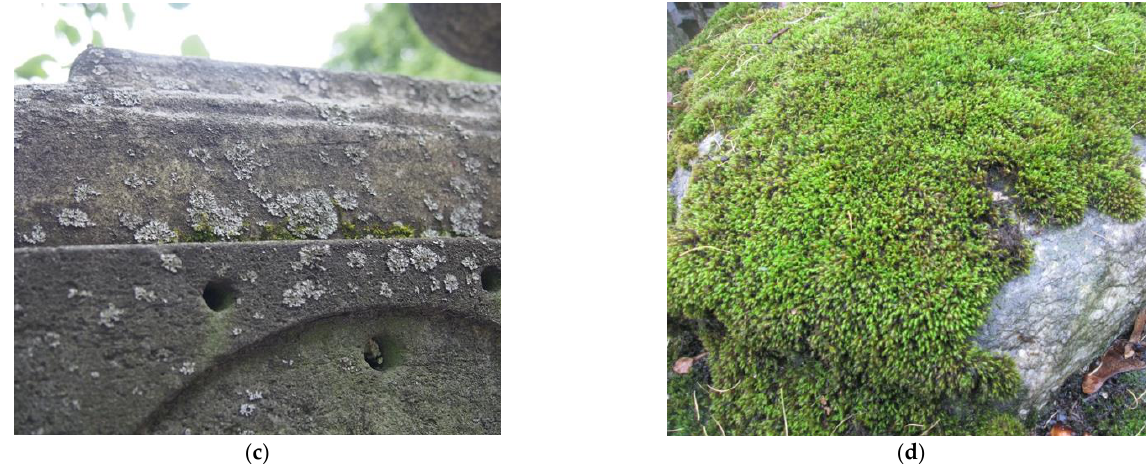
Figure 4. The main types of biolayers on the surface of stone monuments of the historical necropolises: ( a ) biolayers with a predominance of microscopic algae; ( b ) biolayers with a predominance of fungi; ( c ) biolayers, including individual tussocks of mosses and lichen thalli; ( d ) moss and primary soil under the moss cover